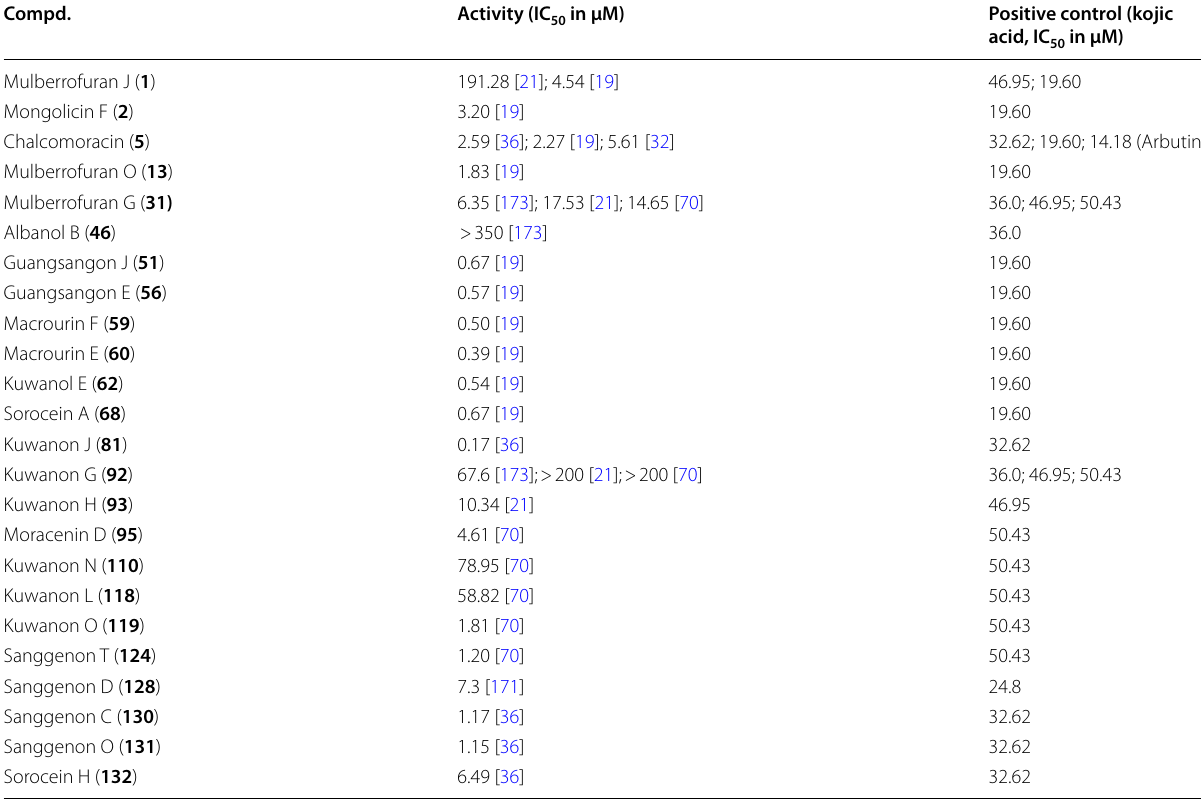
Table 8 Inhibitory activities of MDAAs against tyrosinase